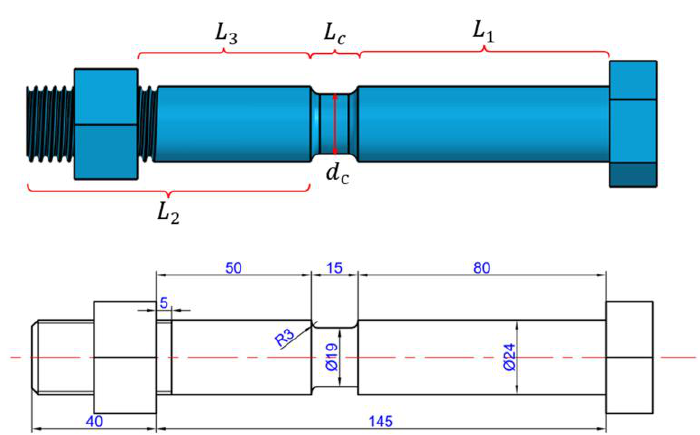
Figure 5. Key geometry used to determine the shape of the VCSB (unit: mm).